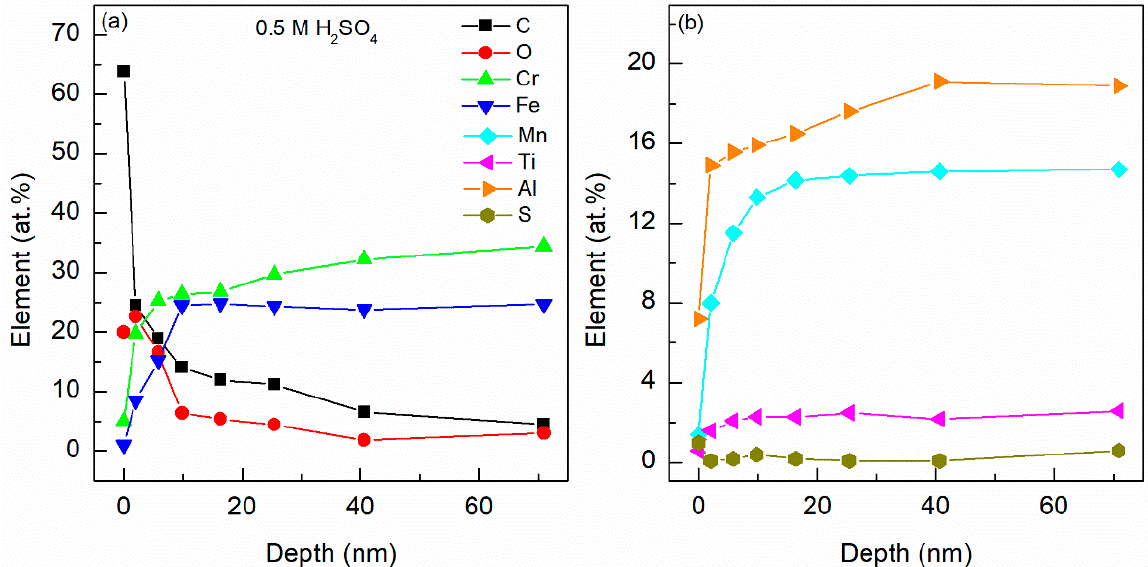
Figure 9. XPS showing depth profiles and elemental analysis (at.%) for Al 10 Cr 30 Fe 25 Mn 30 Ti 5 HEA in 0.5 M H 2 SO 4 : ( a ) C, O, Cr, Fe, and ( b ) Mn, Ti, Al, and Cl.